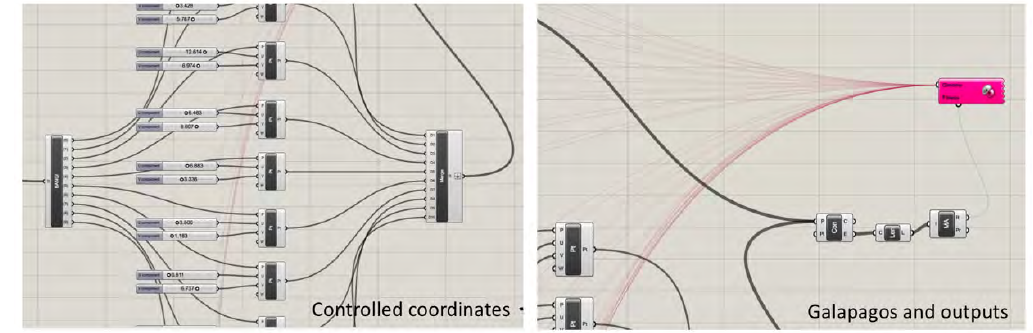
Figure 8. Using Galapagosto control geometry